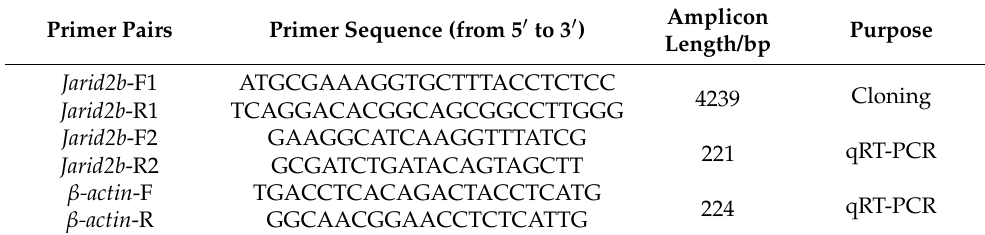
Table 1. Sequence of